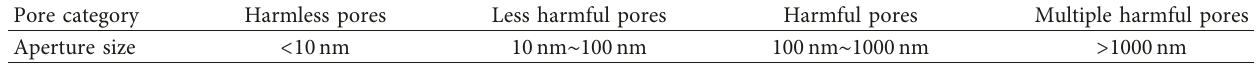
Table 10: Pore grade classification (Liu et al. and Zhang et al.) [23, 43].